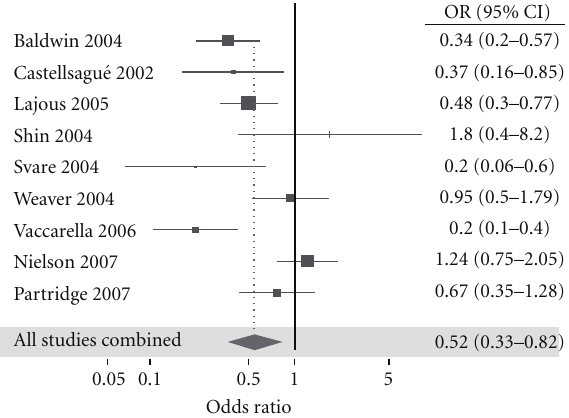
Figure 2: Di ff erence in prevalence of high-risk HPV types between circumcised and uncircumcised men.